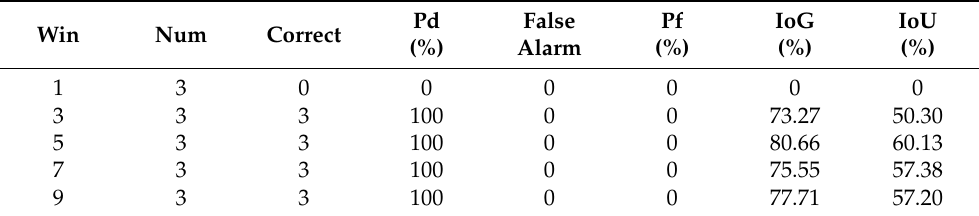
Table 4. Comparison of the detection performance of the TerraSAR-X San Francisco data using the windowed level set segmentation under different window sizes.